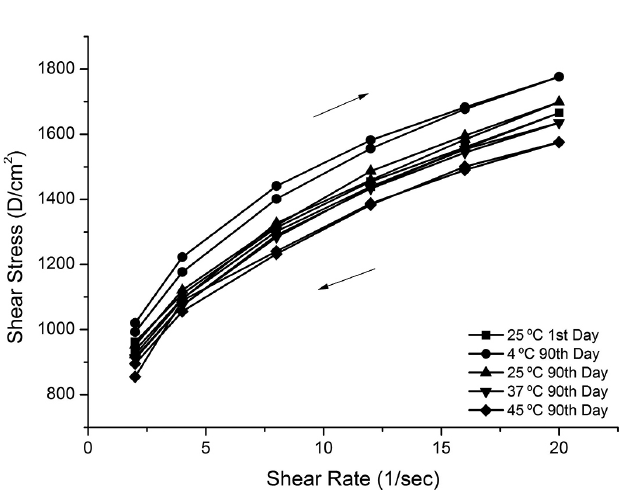
FIGURE 1 - Flow behavior for a stable O/W sunscreens emulsion (R2) 24 h and ninety days after preparation at different